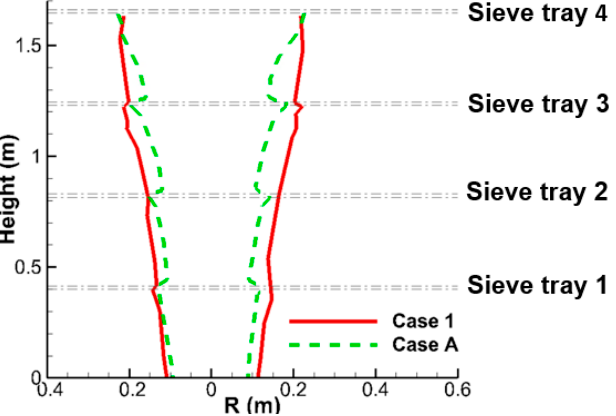
Figure 9. This schematic shows the radius of liquid column of the small-scale tower for Cases 1 and A.